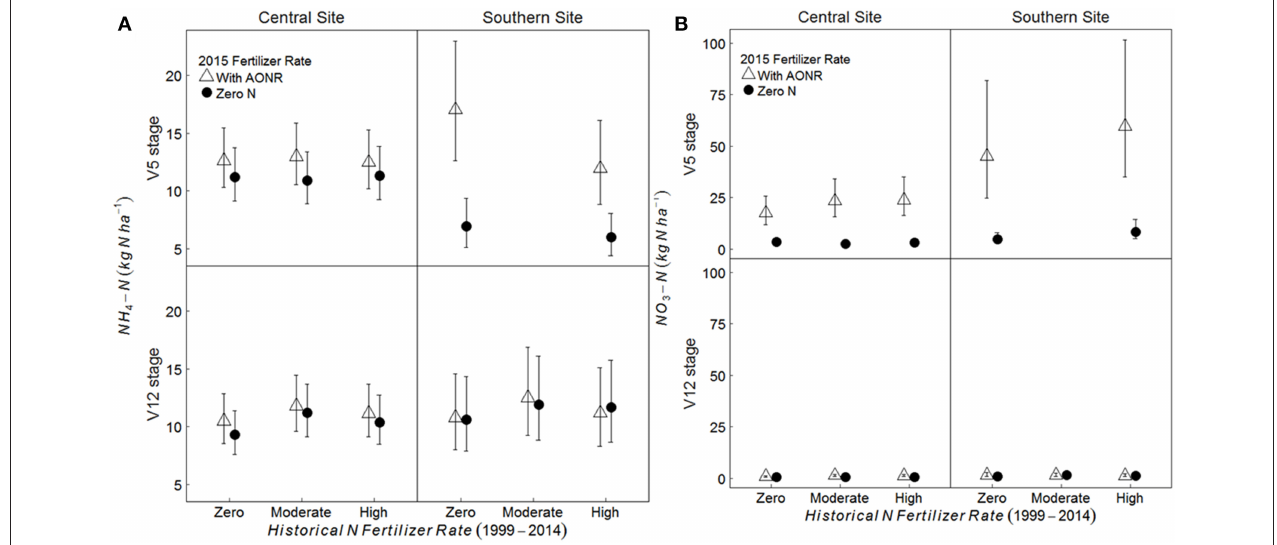
FIGURE 5 | Mean (A) NH 4 -N and (B) NO 3 -N pool sizes (kg N ha − 1 ) from 5 to 15cm soil depth at the V5 and V12 maize growth stages in continuous maize systems in central and southern Iowa in 2015. Experimental plots received one of three historical N fertilizer rates from 1999 to 2014 (zero, moderate, or high). Individual plots received the same N rate every year 1999–2014. In 2015, the historical N rate plots were split and received either zero N or the empirically determined long-term agronomic optimum N rate (AONR). Vertical bars represent 95% confidence intervals. At the southern site, soil samples at the V5 stage were collected only from zero and high historical N rate